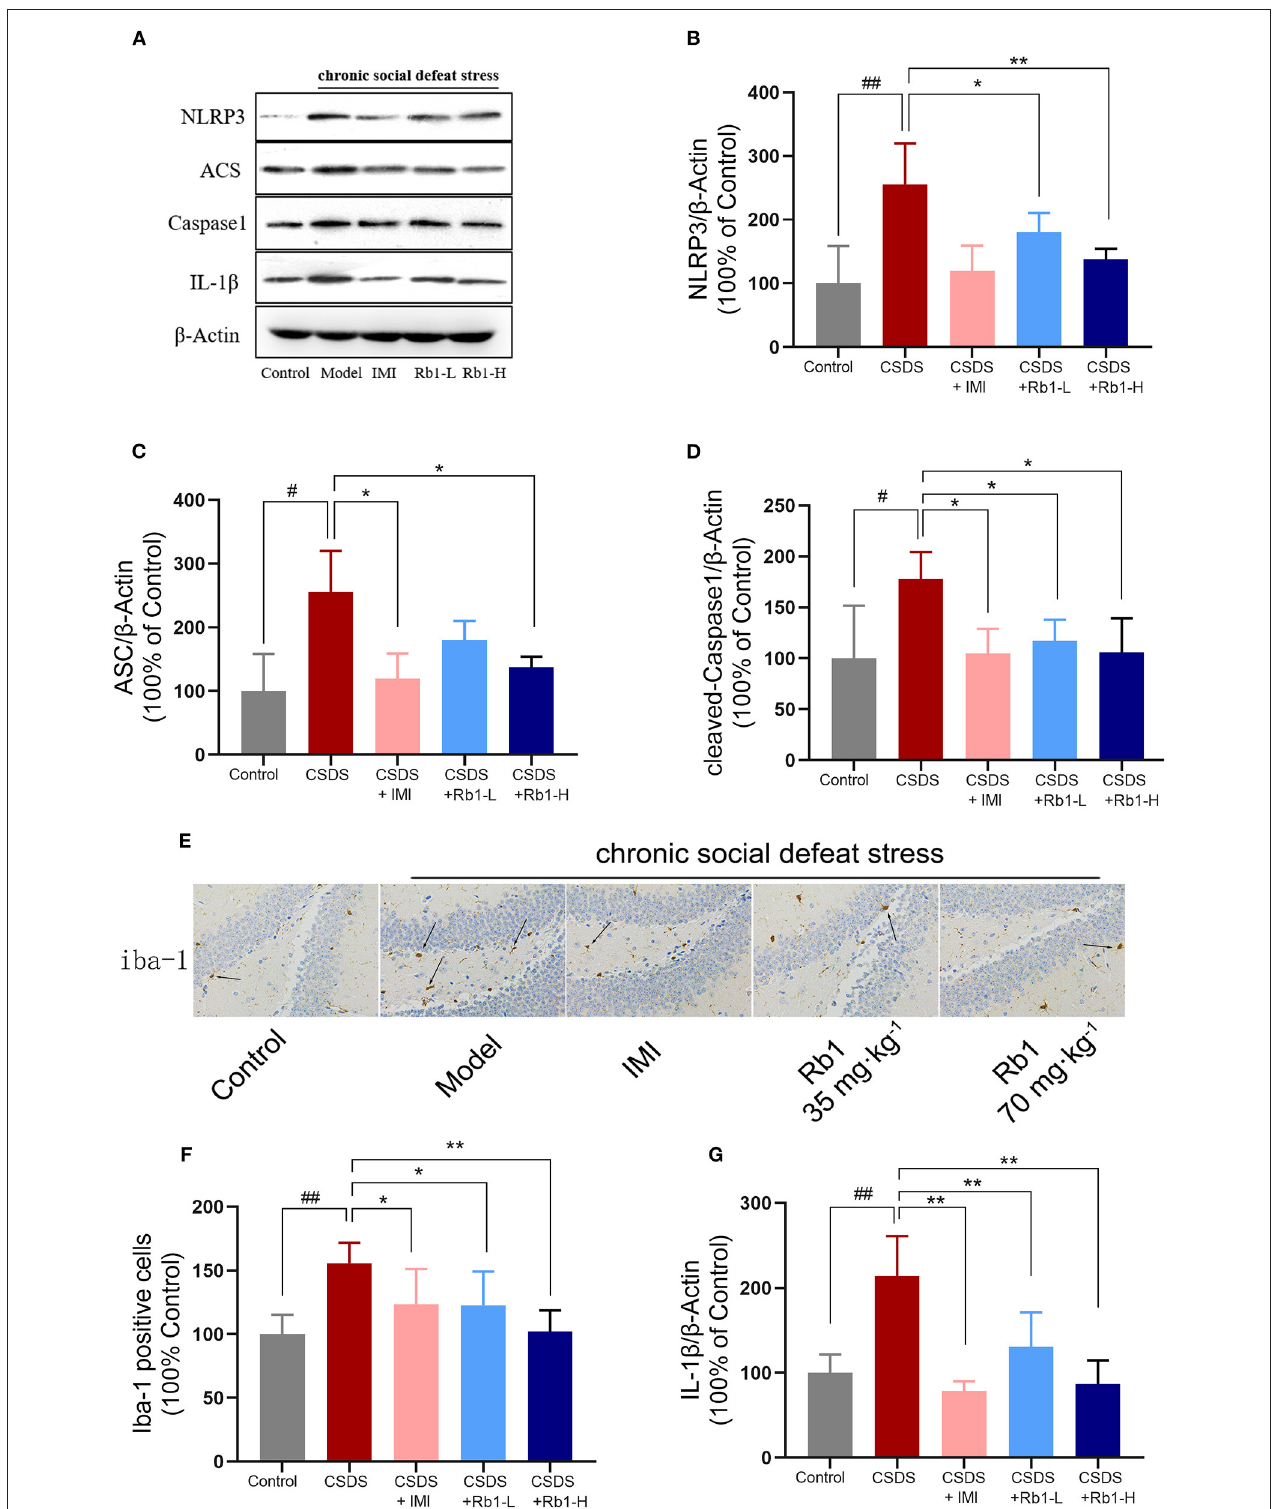
FIGURE 5 | In the hippocampus of CSDS mice, ginsenosides Rb1 reduced the NLRP3 inflammasome and microglial activation. Western blots analysis demonstrates (A) results of protein expression in the hippocampus of CSDS mice; (B) NLRP3; (C) ASC; (D) Cleaved Caspase-1; (G) IL-1 β ; (E) Immunohistochemical staining of Iba-1 in the hippocampus of CSDS mice ( × 400); (F) The number of Iba-1 positive cells. The entire data has been presented are means ± SEM; N = 4 mice per group. # p , and ## p < 0.05, and 0.01, significantly different from control; * p and ** p < 0.05, and 0.01, considerably varied from CSDS group.